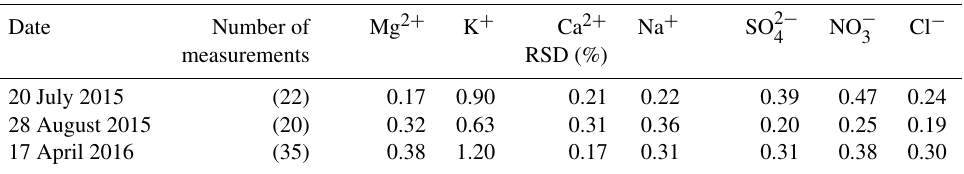
Table 2. Precision on concentration measurements of the whole RL system calculated as the relative standard deviation (RSD) of concentra- tion measurements made over three 24h closed-loop experiments, during which the inlet and the outlet of the primary circuit are connected through a 300L tank of river